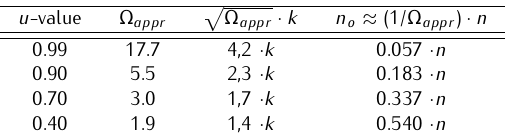
Table 1. The effect of correlation: confidence intervals are enlarged, and the number of effective observations is reduced. Stated u -values refer to the Gaussian-type correlation function in Eq. (27)